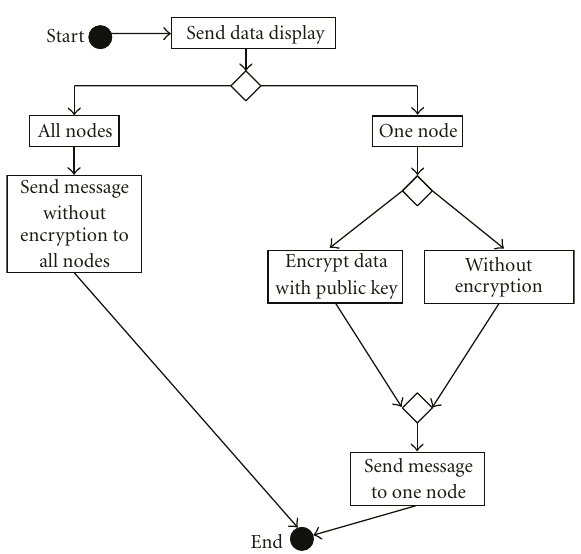
Figure 7: Data transmission